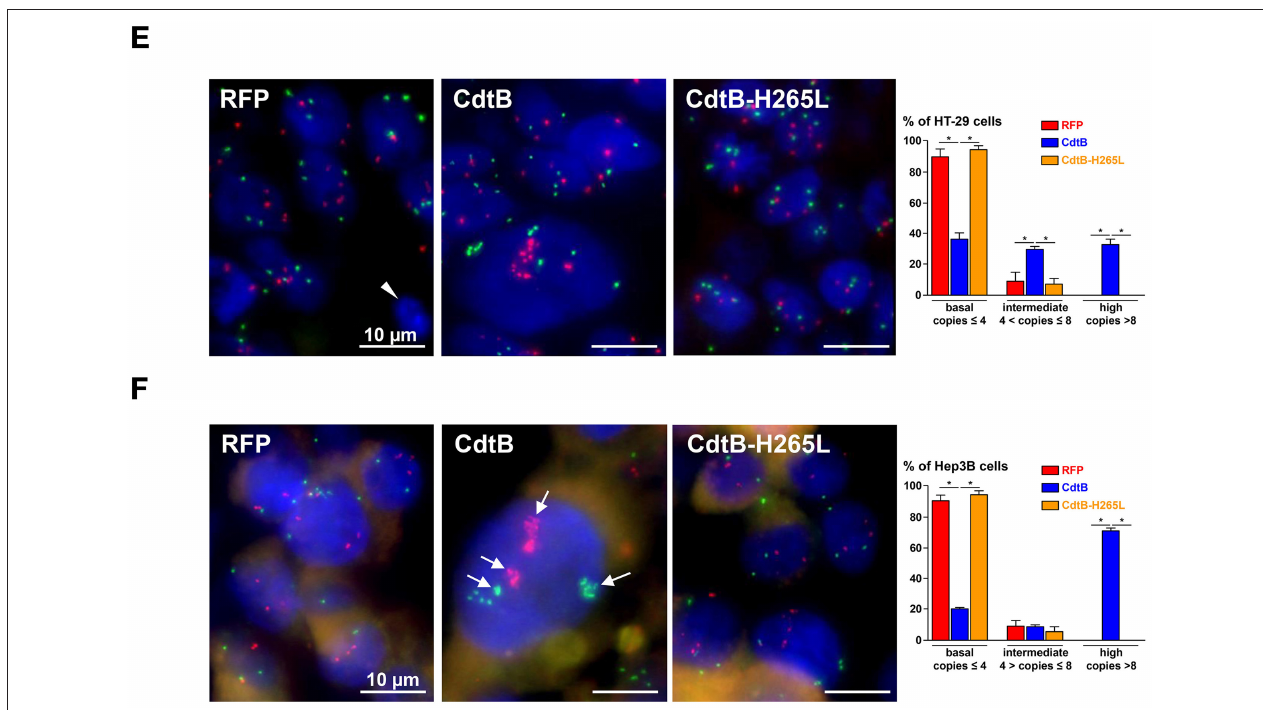
FIGURE 5 | Effect of Helicobacter hepaticus CdtB expression in tumor xenografts. Three µ m-tissue sections of HT-29- and Hep3B-derived tumors were prepared from formalin-fixed paraffin-embedded tissues and submitted to standard hematoxylin staining and immunostaining raised against primary anti-human Ki-67 (A), phospho-histone H3 (B) , anti-human cytokeratin 5, 6, 8, 10, 13, and 18 (Pan-CK) (C,D) . Counting of Ki-67- and phospho-histone H3-positive nuclei, as well as quantification of cytokeratin intensity was performed with Image J 1.51 (Schindelin et al., 2015), each count being performed on 1,000 cells per mice. The results for the quantification of cytokeratins are presented as the ratio of the staining intensity normalized to RFP. Yellow tips of arrows in (D) indicate mice stromal cell infiltrates at the periphery of the HT-29-CdtB-tumors and the long red arrow points to individualized cell clusters at the periphery of HT-29-CdtB-derived tumor. Scale bars, 50 µ m. FISH experiments (dual-color hybridizations) of 6 µ m-tissue sections from formalin-fixed paraffin-embedded HT-29- (E) and Hep3B-tumors (F) were conducted with labeled probes hybridizing to the band on the short arm of human chromosome 5 (chromosome region 5p15.2, green) and to the chromosome 15 centromere (red). Each fluorescent spot corresponds to one copy of the chromosome region. Nuclei were counterstained with DAPI (blue). Mice nuclei are not labeled with these 2 human probes. White tips of arrows indicate non-labeled murine cells. In some Hep3B giant cells, foci containing a high number of chromosome copies are accumulated in different regions (long arrows). Scale bars, 10 µ m. Three groups were determined for each condition, based on FISH signals counts: basal level ( ≤ 4 signals per probe per nuclei), intermediate ( > 4 and ≤ 8) and high level ( > 8). The basal level was in accordance to hypertriploid karyotypes of Hep3B and HT-29 cell lines. CdtB, CdtB of H. hepaticus strain 3B1; CdtB-H265L, H. hepaticus CdtB with H265L mutation; DAPI, 4 ′ ,6 ′ -diamidino-2-phenylindol; RFP, red fluorescent protein. * p <